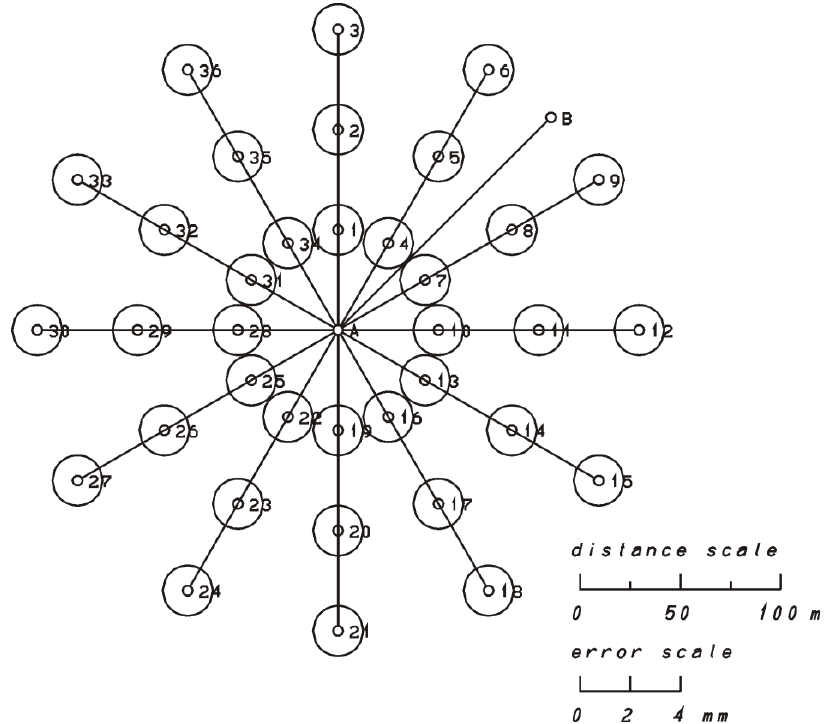
Figure 8. Standard error ellipses for the influence of displacements at control point 𝐶 on the position of control point 𝐶 . Appl. Sci. 2020 , 10 , x 12 of 15